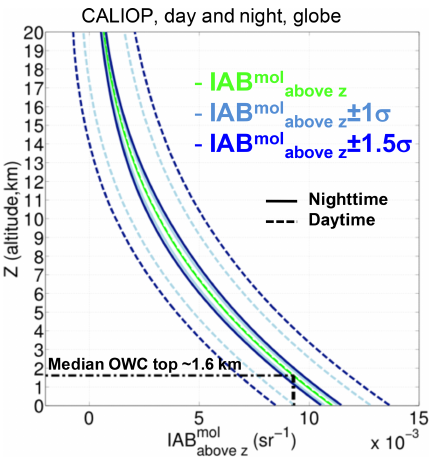
Figure B1. Nighttime (solid) and daytime (dashed) simulated ver- tical profile of integrated attenuated backscatter above any given altitude, z , IAB mol (green curve). The light blue (respectively above z dark blue) envelope shows 1 (respectively 1.5) standard devia- tion ( σ ) around the IAB mol profile. Data were generated by above z the CALIPSO lidar simulator (Powell et al., 2002, 2006). The IAB mol value associated with the median OWC top height of above z ∼ 1 . 6km in our dataset corresponds to 0.0093sr − 1